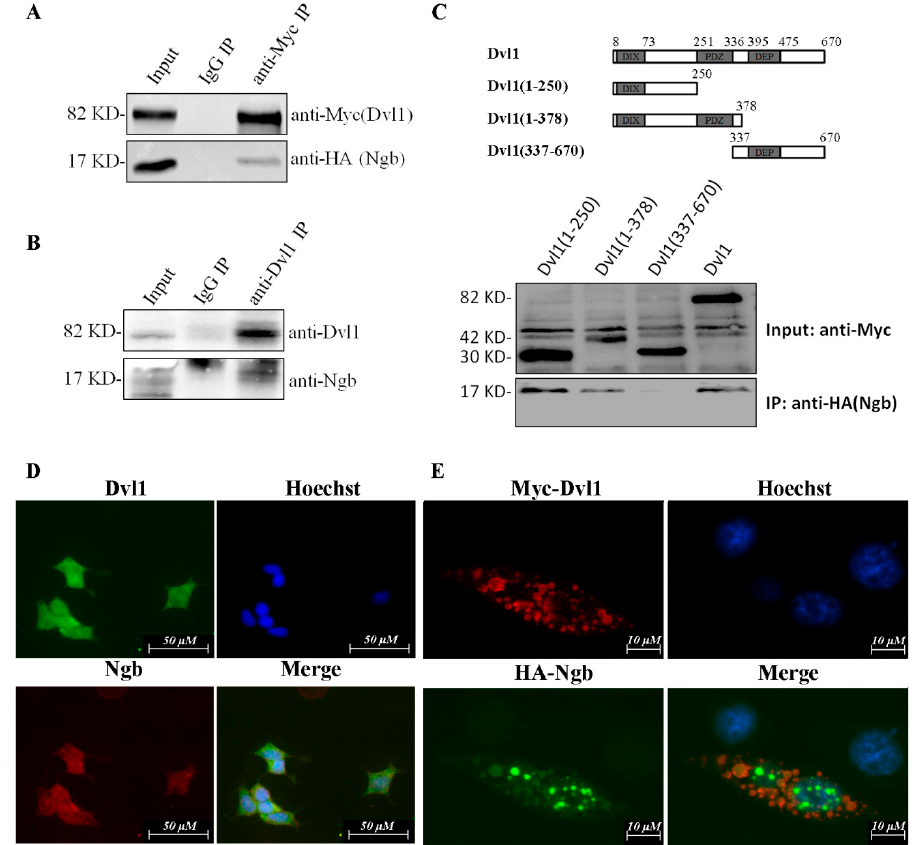
Figure 1. Neuroglobin (Ngb) interacts with Dvl1 in SKNSH cells. ( A ) HA-Ngb was co-transfected with Myc-Dvl1 in SK-N-SH cells. Cells were harvested after 24 h post-transfection. Cells extract (600 μ g) were precipitated by anti-Myc rabbit polyclonal antibody or control Immunoglobulin G (IgG). Western blot was used to detect Myc-Dvl1 and HA-Ngb. ( B ) Cells extract (600 μ g) were prepared and immunoprecipitation (IP) with rabbit anti-Dvl1 antibody or control rabbit IgG. Western blot was used to detect Dvl1 and Ngb. ( C ) Dvl1(1-250), Dvl1(1-378), Dvl1(337-670) or Myc-Dvl1 was co-transfected with HA-Ngb. After 24 h post-transfection, cells were harvested and IP with mouse anti-Myc monoclonal antibody. Western blot was used to detect Ngb. ( D ) SK-N-SH cells were seeded in 6-well plate. The mouse anti-Ngb monoclonal antibody and Texas Red-conjugated anti-mouse IgG (red) were used to detect Ngb protein. The rabbit anti-Dvl1 monoclonal antibody and Texas Green-conjugated anti-rabbit IgG were used to detect Dvl1 protein. Nuclei were stained by Hoechst 33258. The merged image showed the co-localization of Dvl1 and Ngb. ( E ) SK-N-SH cells were co-transfected with Myc-Dvl1 and HA-Ngb. The rabbit anti-HA polyclonal antibody and Texas Green-conjugated anti-rabbit IgG were used to detect HA-Ngb protein. The mouse anti-Myc monoclonal antibody and Texas Red-conjugated anti-rabbit IgG were used to detect Myc-Dvl1 protein. Nuclei were stained by Hoechst 33258. The merged image showed the co-localization of Myc-Dvl1 and HA-Ngb.